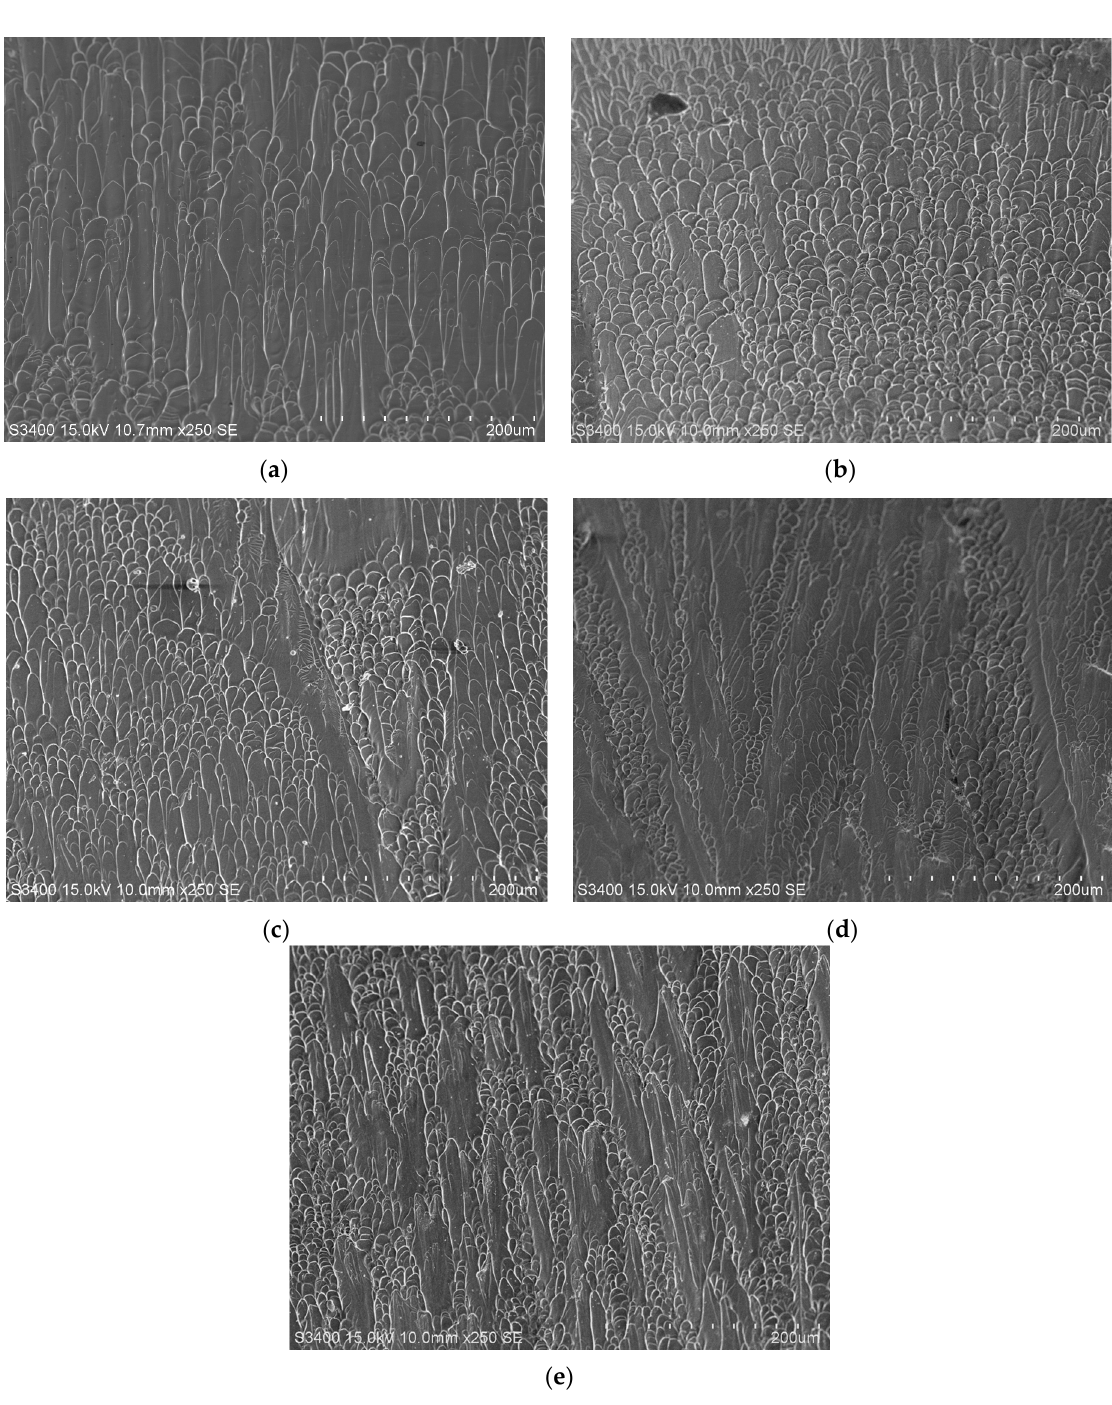
Figure 4. SEM images of the compressive fracture surface of Cu 50 − x Zr 43 Al 7 Ag x alloys: ( a ) x = 0, ( b ) x = 3, ( c ) x = 4, ( d ) x = 5, and ( e ) x = 6.